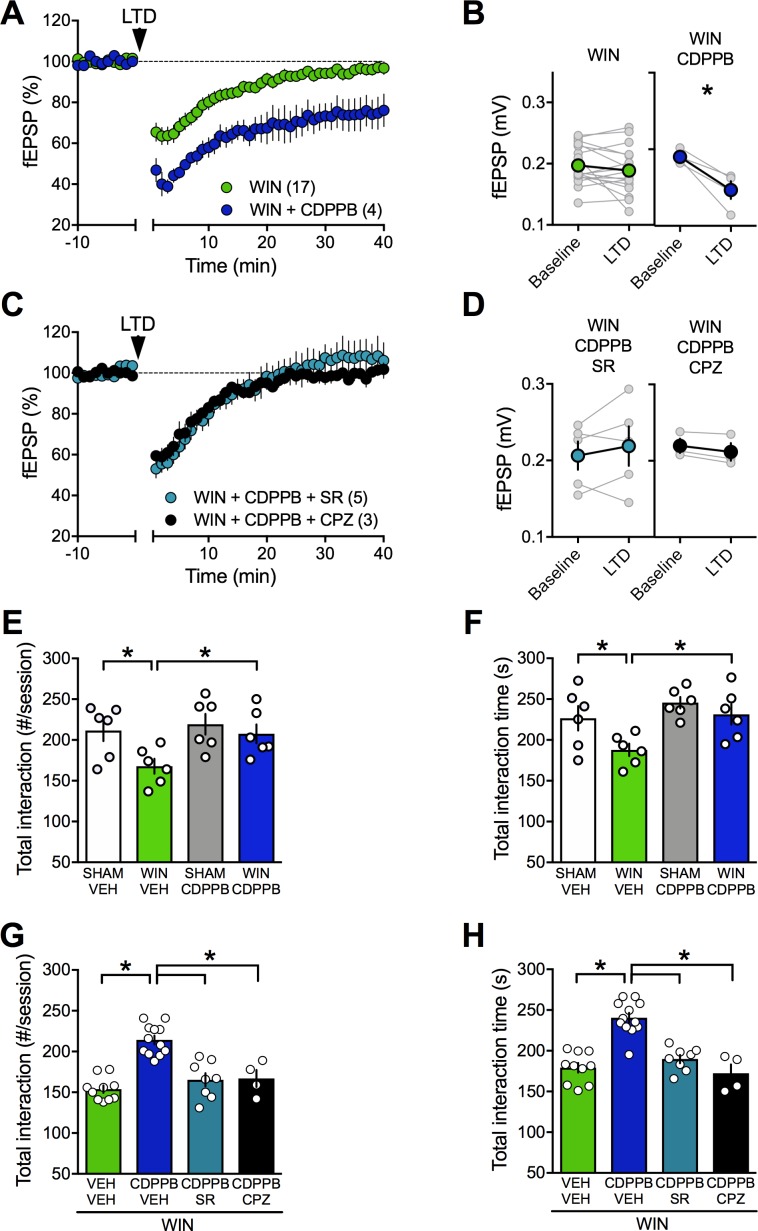
Positive allosteric modulation of mGlu5 restores LTD and normalizes social interaction in male rats prenatally exposed to WIN.(A) Average time-courses of mean field EPSPs showing that, in WIN-exposed males (WIN, n = 17, green circle), LTD can be restored with the mGlu5positive allosteric modulator CDPPB (10 μM, n = 4, blue navy circle). (B) Peak amplitude measurements before (baseline) and after (LTD) stimulation protocol from individual experiments in absence or presence of CDPPB. After 45 min CDPPB preincubation: 0.190 ± 0.004 mV before and 0.147 ± 0.012 after LTD induction (n = 4, p<0.05, paired t-test). (C) Time course of fEPSP during 10 Hz stimulus evoked LTD (arrow, 10 min) in presence of CB1R antagonist SR141716 (SR, 4 μM, n = 5, blue circles) or TRPV1 antagonist Capsazepine (CPZ, 10 μM, n = 3, black circles) in WIN-exposed males. (D) Individual averaged fEPSP amplitude experiments before (baseline) and 40 min after 10 Hz LTD stimulation (LTD). CB1R were necessary for the CDPPB effect on LTD: SR141716A preincubation blocked LTD induction in the presence of CDPPB: 0.206 ± 0.019 mV before and 0.217 ± 0.026 (blue circle, n = 5, p>0.05, paired t-test). Similarly, the TRPV1 antagonist inhibits the restorative effects of CDPPB: 0.220 ± 0.009 mV before LTD and 0.212 ± 0.012 mV after LTD induction (black circle, n = 3, p<0.05, paired t-test). (E–F) Systemic administration of CDPPB (0.75 mg/Kg, i.p.) normalized the altered social behavior in male rats prenatally exposed to WIN (number of contacts: E: F(WIN in utero x CDPPB)1,20=1.867, p=0.187, two-way ANOVA; time interaction: F: F(WIN in utero x CDPPB)1,20=1.607, p=0.219, two-way ANOVA). (G-H) Pre-treatment with SR141716A (1 mg/kg, i.p.) prevents the ameliorative actions of CDPPB (0.75 mg/Kg, i.p.) on social interaction. Similarly, the TRPV1 antagonist blocks the restorative effects of CDPPB on social interaction in adult rats prenatally exposed to WIN (number of contacts: G: F3,30=22.36, p<0.05, one-way ANOVA; time interaction: H: F3,30=25.95, p<0.05, one-way ANOVA). Scatter dot plot represents a pair of animals. Error bars indicate SEM. *p<0.05. Student–Newman–Keuls test.